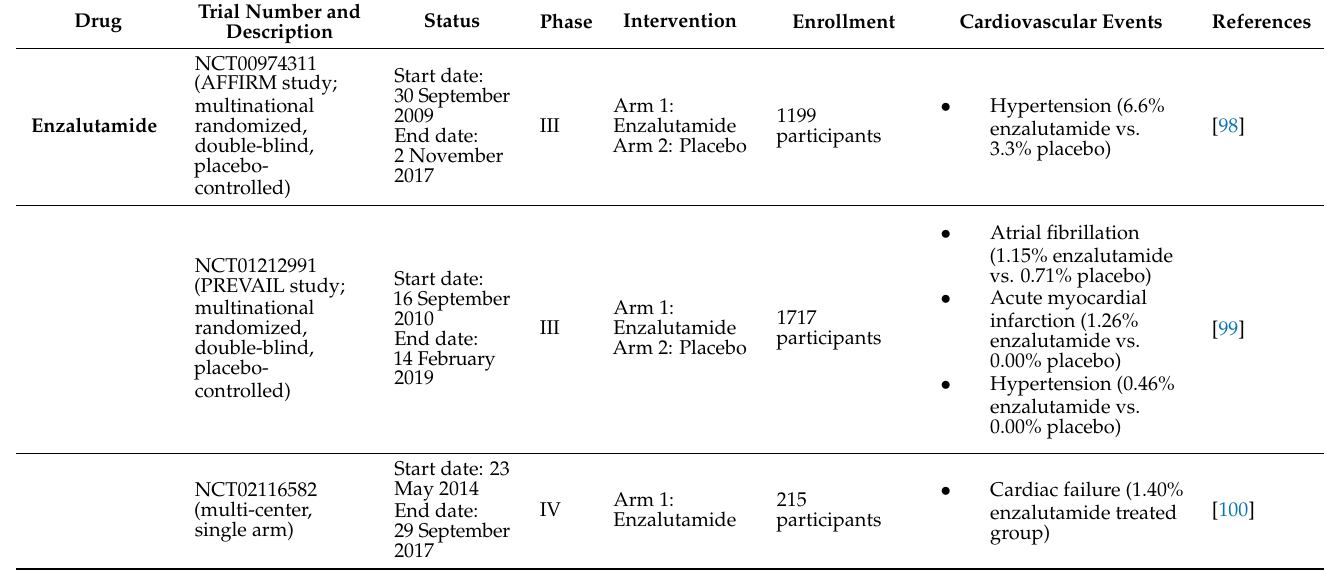
Table 2. Cardiovascular events observed with the second-generation